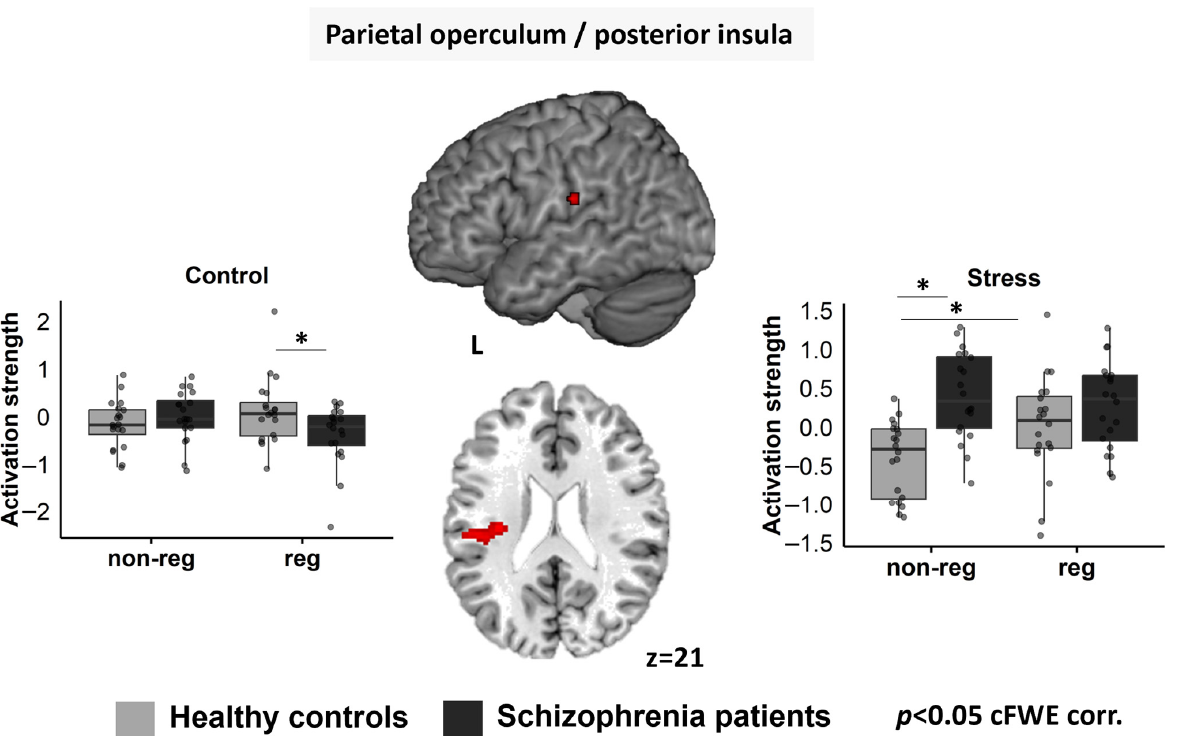
Figure 3. The cluster in the pOP/pI (red) showed a significant interaction “regulation-by-condition-by-group” on whole-brain level: HC showed stronger activation than SZP during the control condition in the regulation block ( left ). SZP showed higher activation than HC during the stress condition in the non-regulation block ( right ). HC showed higher activation during stress in the regulation block compared to the non-regulation block ( right ). non-reg = non-regulation block; reg = regulation block; L = left. Significant differences are marked with *.